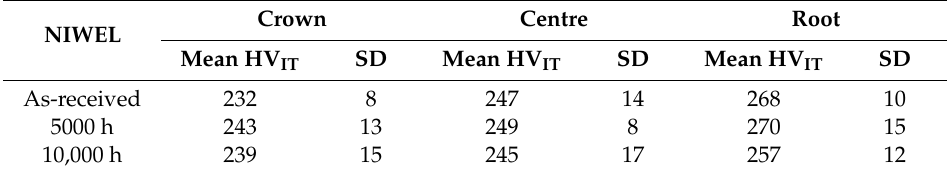
0200210220230240250260270280290300 Figure 5. Comparison of the hardness profiles across the LAS HAZ in the NIWEL DMW before and after thermal ageing at 400 °C for 5000 and 10,000 h, showing a clear correlation with the grain size profile. Table 2. Hardness variation in Alloy 52 weld metal in the NIWEL DMW from the weld crown to the weld root, before and after ageing at 400 ◦ C for 5000 and 10,000 h (SD: standard deviation). Crown Centre NIWEL